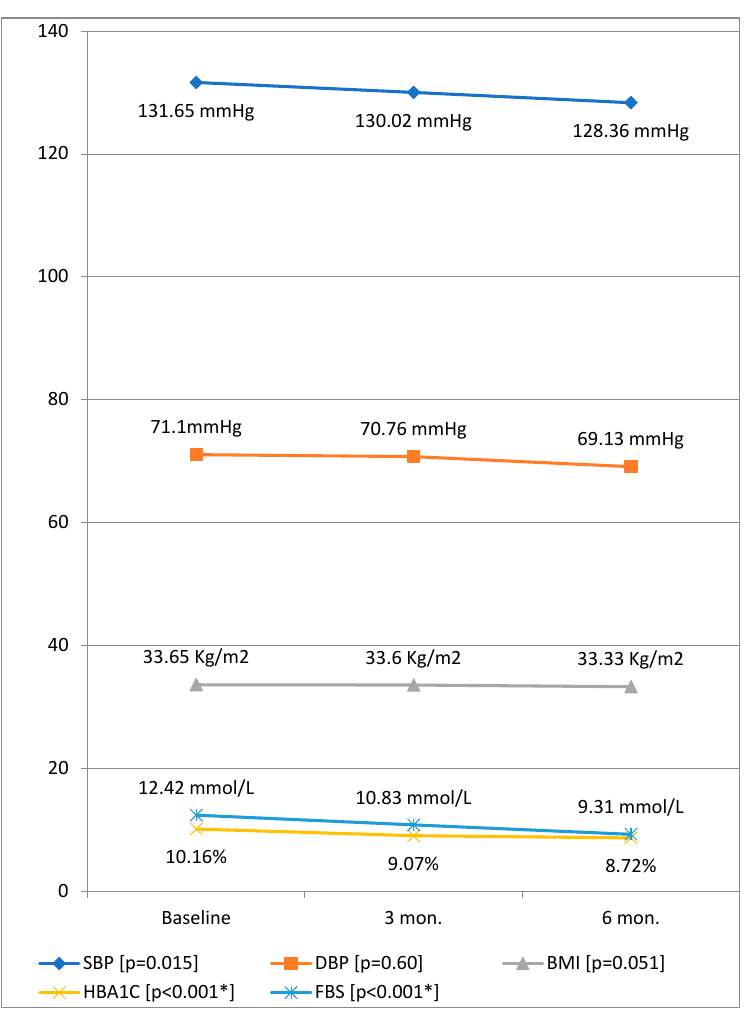
Figure 1. Mean values of HbA1c and other clinical parameters before and after education intervention among participants. Note: BMI—body mass index, SBP—Systolic blood pressure, DBP—diastolic blood pressure, HBP—High blood pressure, TC—Total cholesterol, LDL—low density lipoprotein, HDL—high density lipoprotein, TG—triglycerides, HbA1c—Hemoglobin A1c, FBS—fasting blood sugar, *__statistically significant.